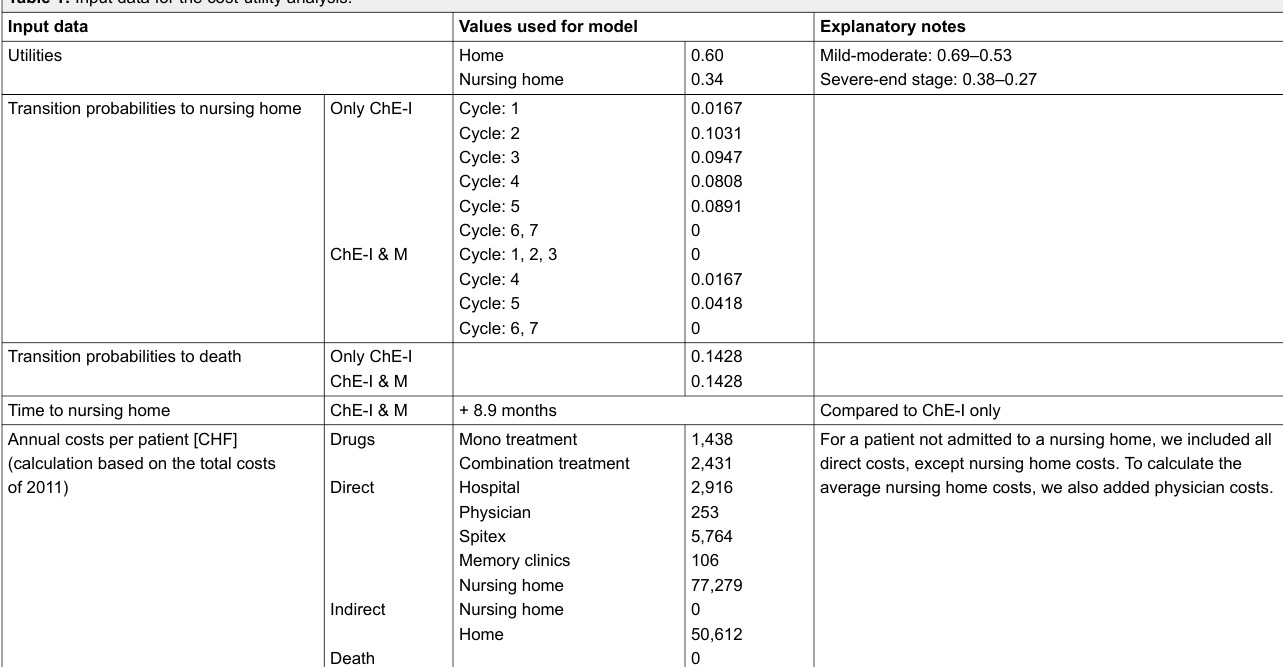
Table 1: Input data for the cost-utility analysis. Input